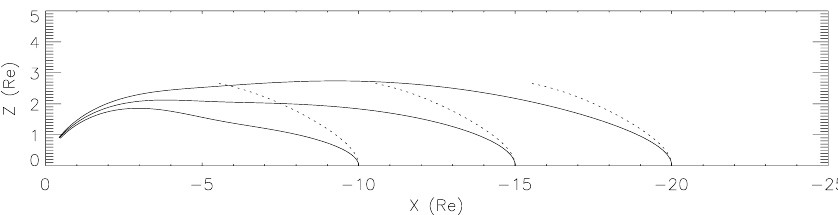
Fig. 6. Comparison between the special field line (dashed lines) taken from Tsyganenko (96) magnetospheric magnetic field model (with the parameters set as the solar wind density 6 per cubic centimeter, velocity 380kms − 1 , IMF B z = 5nT and Dst=0nT) with equatorial plane crossing point at − 10 R E and the field lines taken from the same model (with the parameters set as the solar wind density 6 per cubic centimeter, velocity 380kms − 1 , IMF B z = − 5nT and Dst= − 80nT) with equatorial plane crossing point at − 10 R E , − 15 R E and − 20 R E .